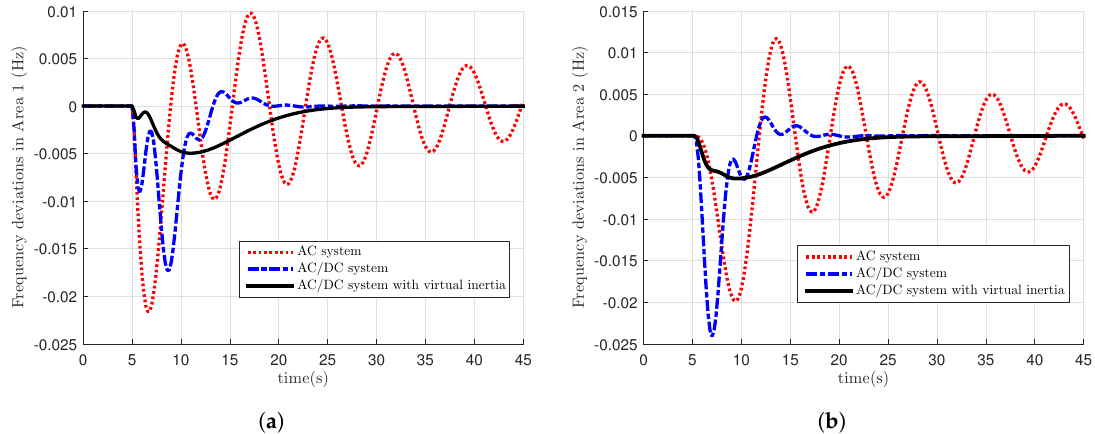
Figure 2. Results of both areas when there is a step load change in Load 1 of Area 1 in the two-area power system. ( a ) Frequency deviation of Area 1. ( b ) Frequency deviation of Area